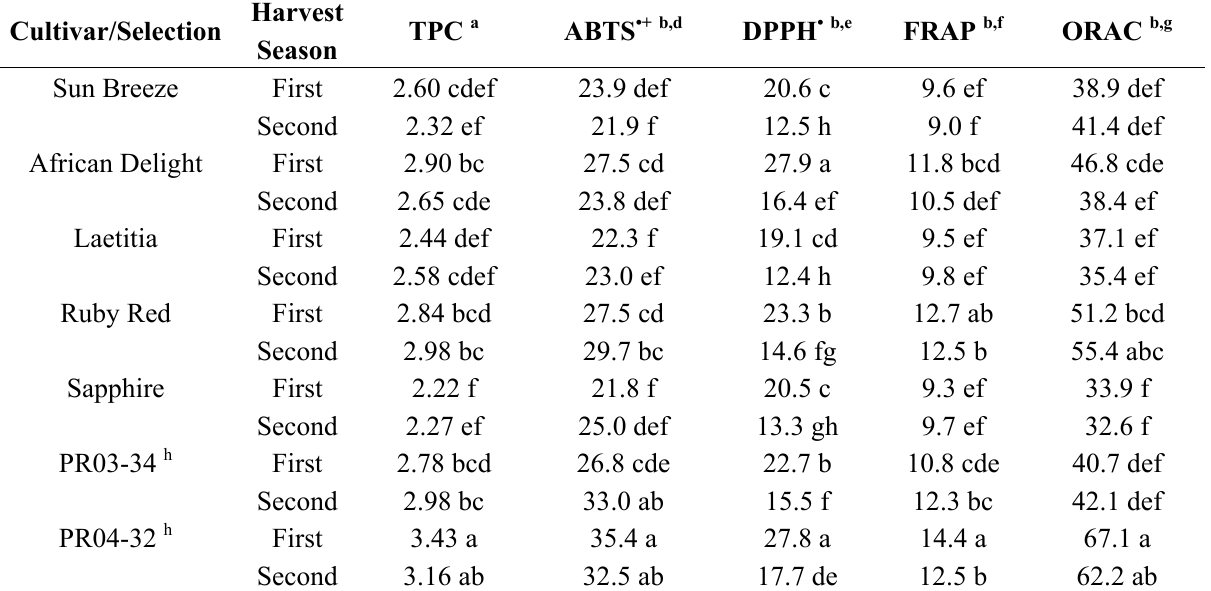
Table 7. Total polyphenol content (TPC) a and total antioxidant capacity (TAC) b for ripe fruits from South African plum ( Prunus salicina Lindl.) cultivars and selections harvested during two consecutive harvest seasons c